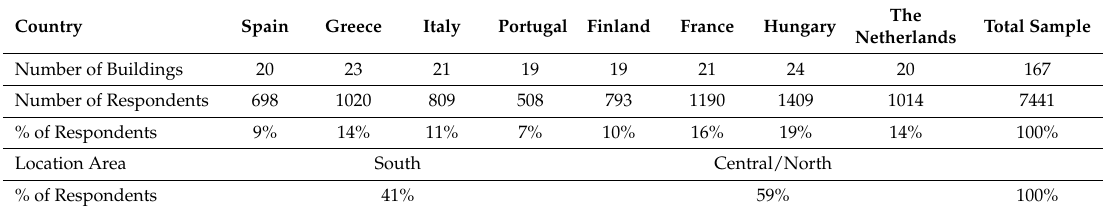
Table 2. Distribution of buildings and respondents per country and location area in OFFICAIR study.